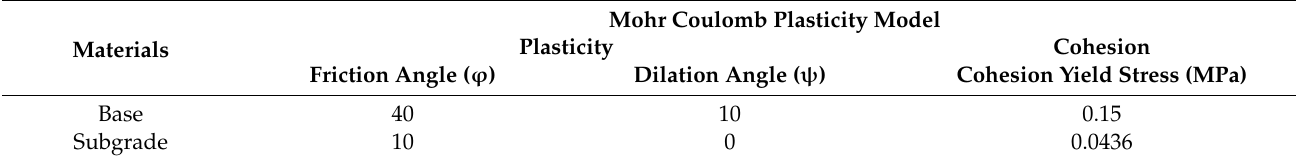
Table 2. Mohr–Coulomb Plasticity model parameters for the base and subgrade